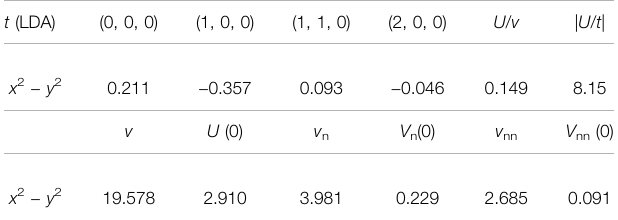
TABLEA1| Transferintegralandeffectiveinteractionintheone-bandHamiltonian for YNiO 2 (in eV). Both the one-body and two-body parts in the Hamiltonian are derived based on the LDA band structure. v and U (0) represent the bare Coulomb interaction and the static value of the effective Coulomb interaction, respectively (at ω =0). The index “ n ” and “ nn ” represent the nearest unit cell [1,0,0] and the next-nearest unit cell [1,1,0], respectively.